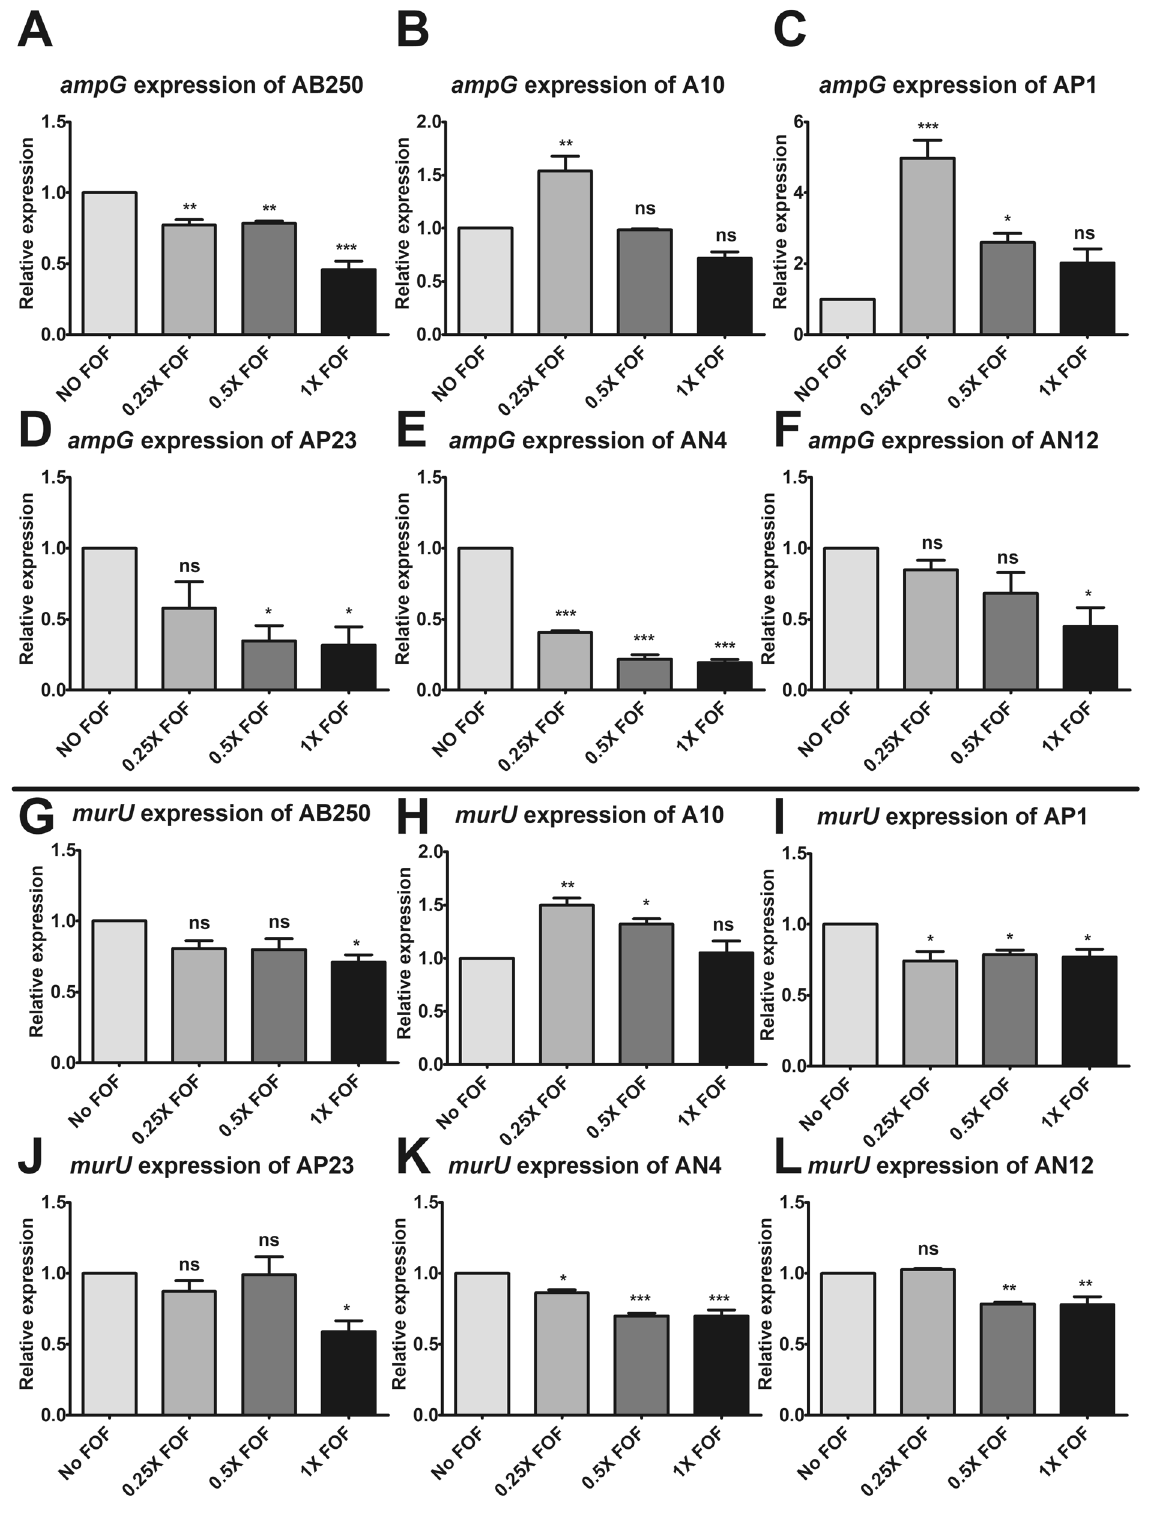
Figure 4. Relative mRNA expression of ampG in the presence of fosfomycin was determined by RT-PCR assay in A. baumannii AB250 ( A ) and A10 ( B ), A. pittii AP1 ( C ) and AP23 ( D ), and A. nosocomialis AN4 ( E ) and AN12 ( F ). Relative mRNA expression of murU in the presence of fosfomycin was determined by RT-PCR assay in A. baumannii AB250 ( G ) and A10 ( H ), A. pittii AP1 ( I ) and AP23 ( J ), and A. nosocomialis AN4 ( K ) and AN12 ( L ). The relative mRNA expressions at each condition (in the presence of 0.25× MIC, 0.5× MIC, or 1× MIC of fosfomycin) were normalized to 16S rRNA expression and compared to the mRNA expression level of each isolate in the absence of fosfomycin. All experiments were performed in triplicate. Mean values of the relative mRNA expression were plotted with error bars representing the standard error of the mean (n = 3). The p -values were calculated using one-way ANOVA, Dunnett’s multiple comparison test (* p -value ˂ 0.05; ** p -value < 0.01; *** p -value < 0.001 and ns,